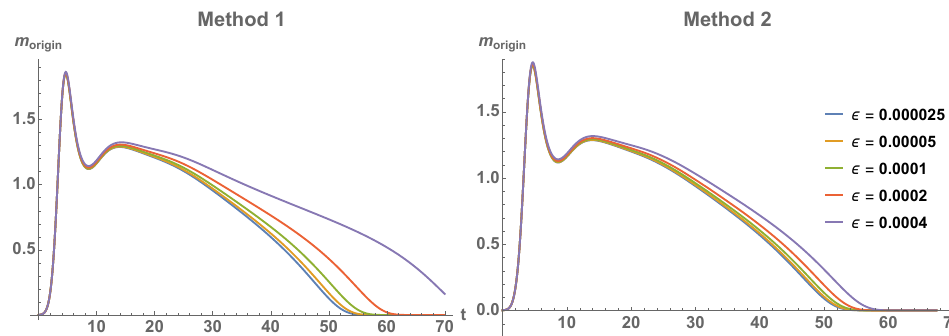
Figure 16 . Dependence of m origin on the low-mass cuto(cid:11) (cid:15) , as a function of time, for the two kinds of cuto(cid:11) introduced in Methods 1 and 2.